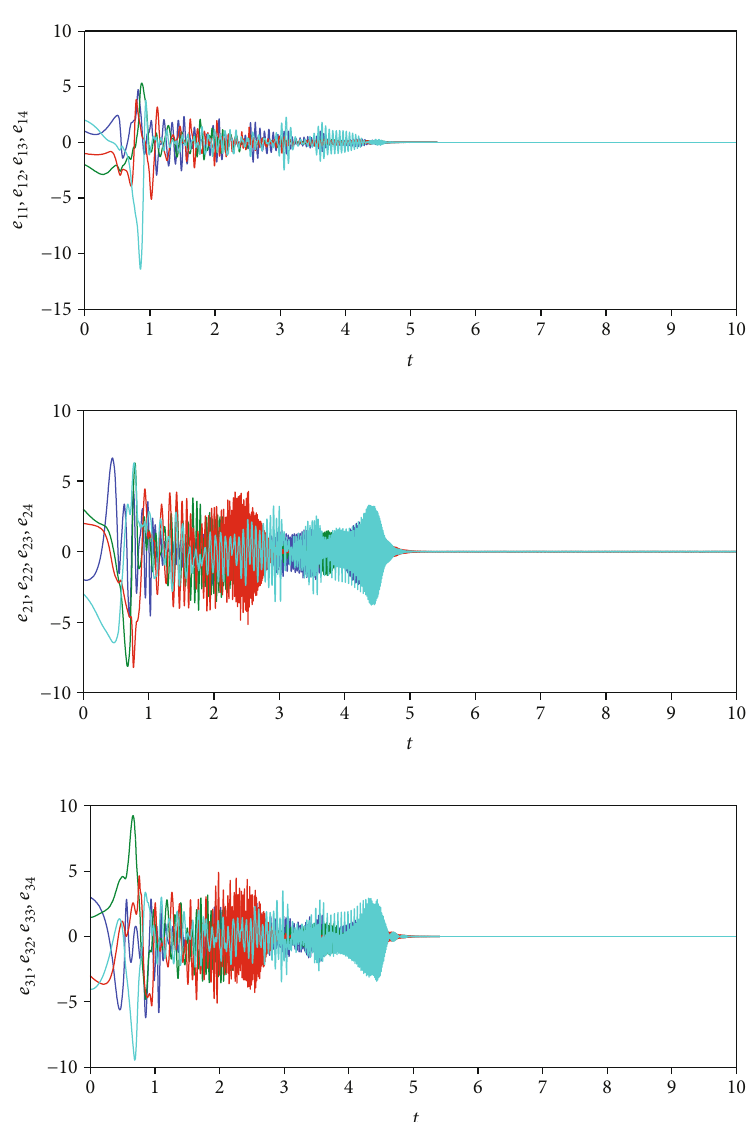
Figure 3: The synchronous errors of the triweight complex network with the same